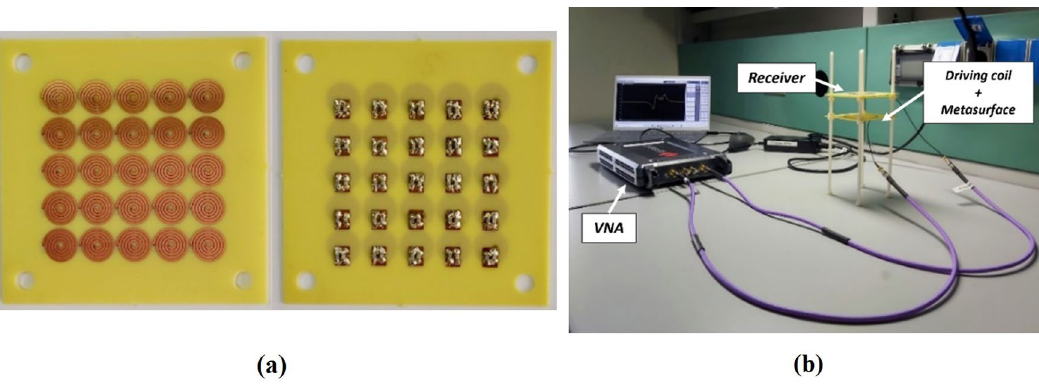
Figure 4. Experimental set-up: ( a ) picture of the PCB metamaterial slab; ( b ) measurement set-up of the WPT system in the presence of the metasurface.